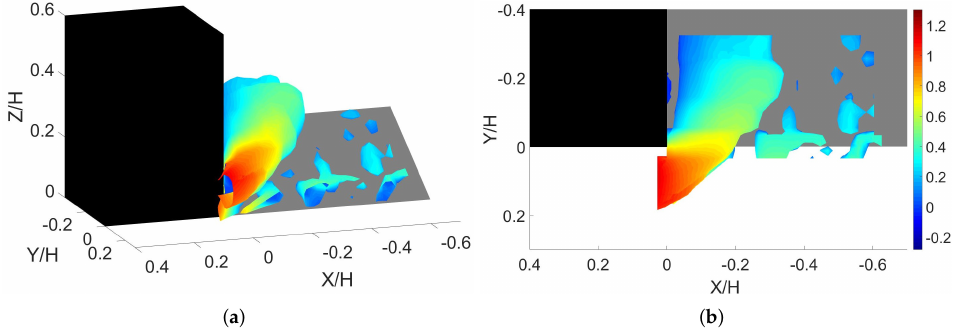
Figure 11. ( a – c ) Instantaneous non-dimensional velocity vectors plotted over the ω ∗ planes perpendicular to the main flow direction to show that OV is pronounced in the immediate vicinity of the retaining wall.